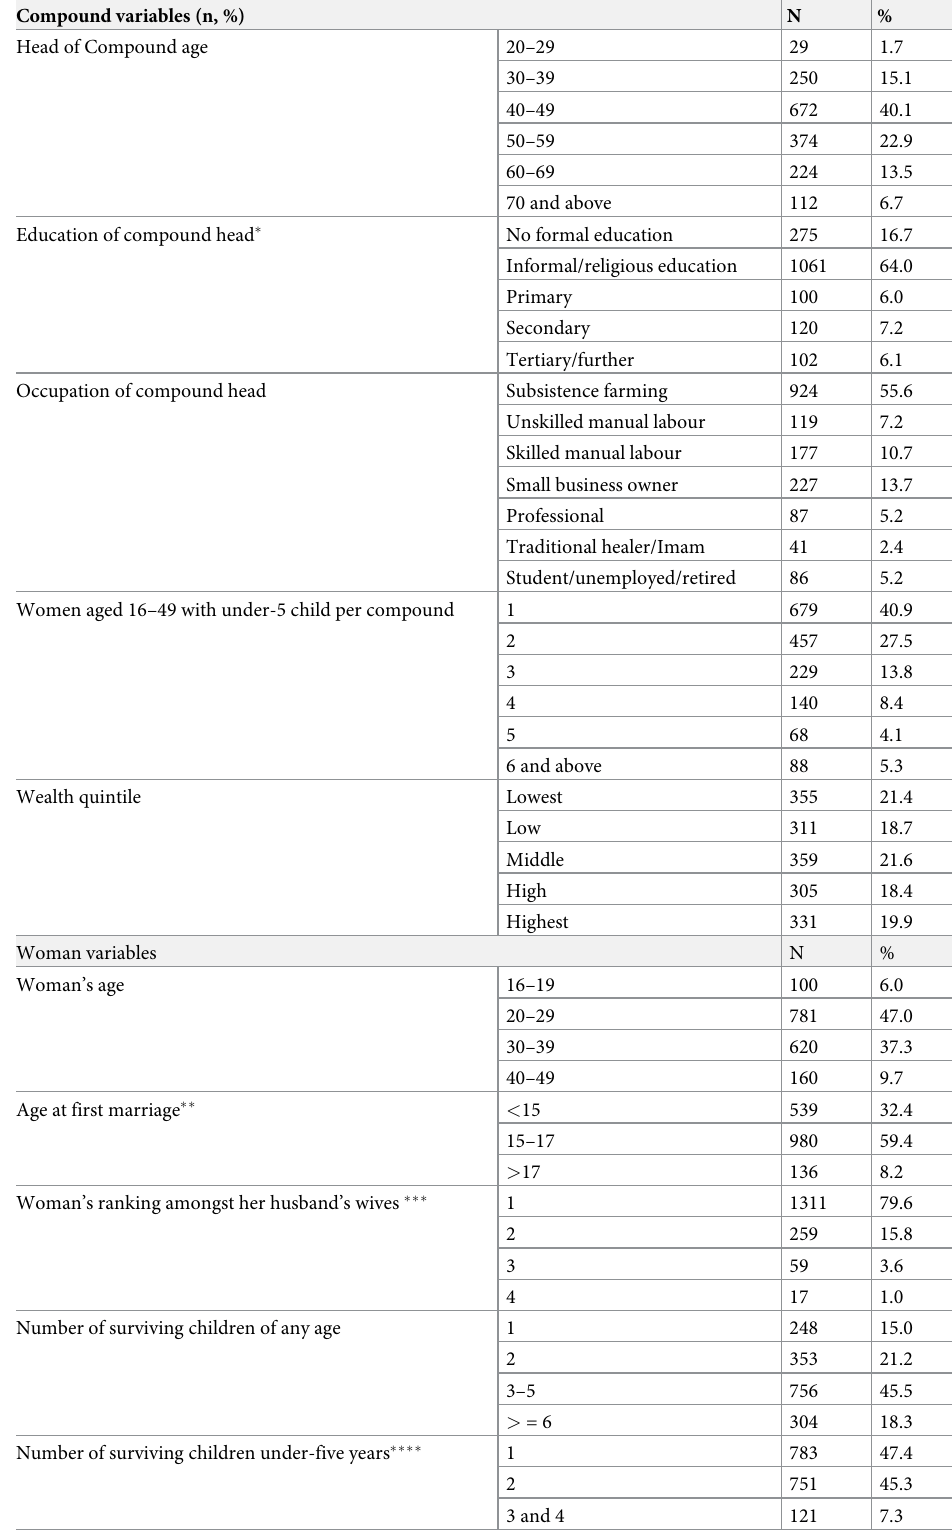
Table 1. Socio-economic and demographic status of women and compound head (n =